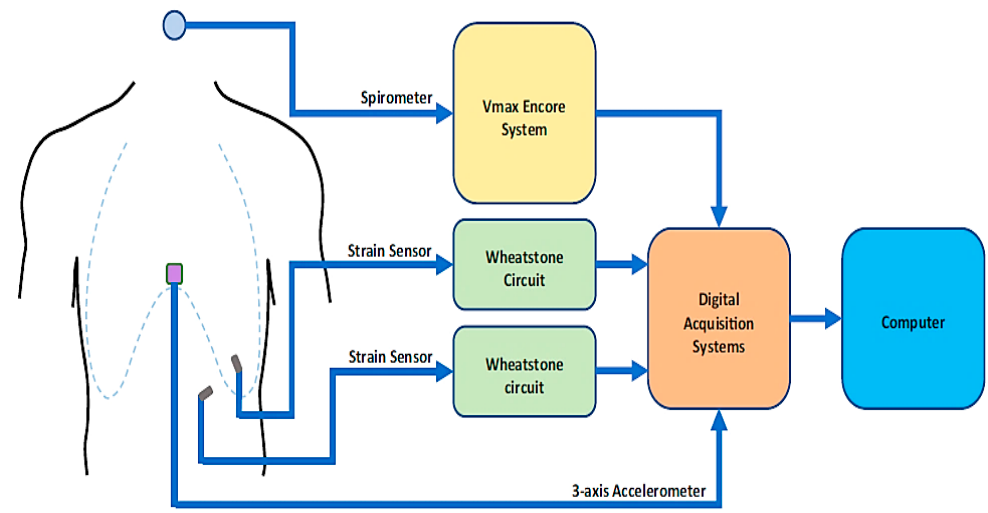
Figure 10. Schematic representation of the hardware setup employed for the tests [61].